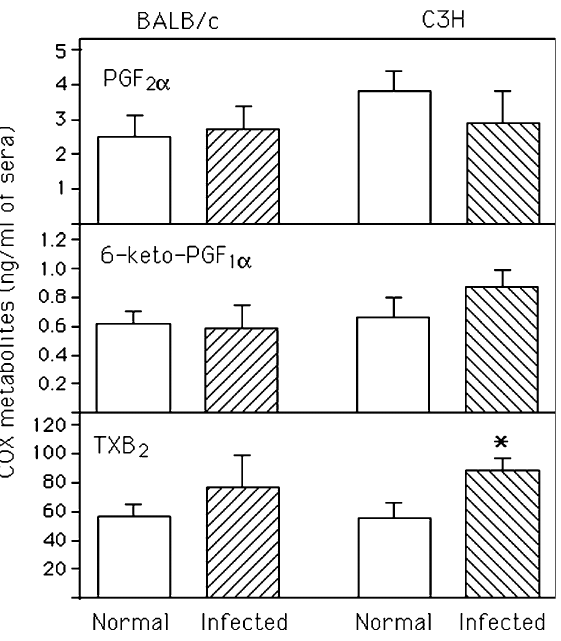
FIG. 4. Circulating levels of PGF 2 a , 6-keto-PGF 1 a and TXB 2 in mice chronically infected with T. cruzi ( (cid:3) / 180 days p.i.) (hatched bars) and in age-matched non-infected controls (open bars). Means 9 / standard errors of 4 (cid:1) / 6 mice/group are shown. *Differences with non-infected mice are significant (p B / 0.05,